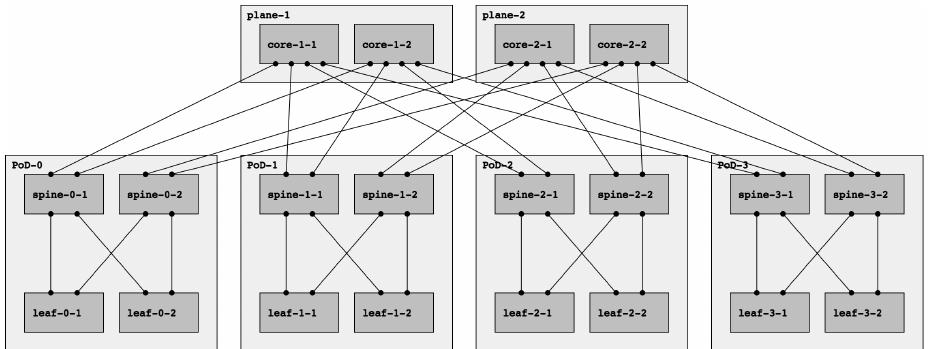
Figure 1. A fat-tree multi-plane topology with K = 2, R = 1 and N = 2